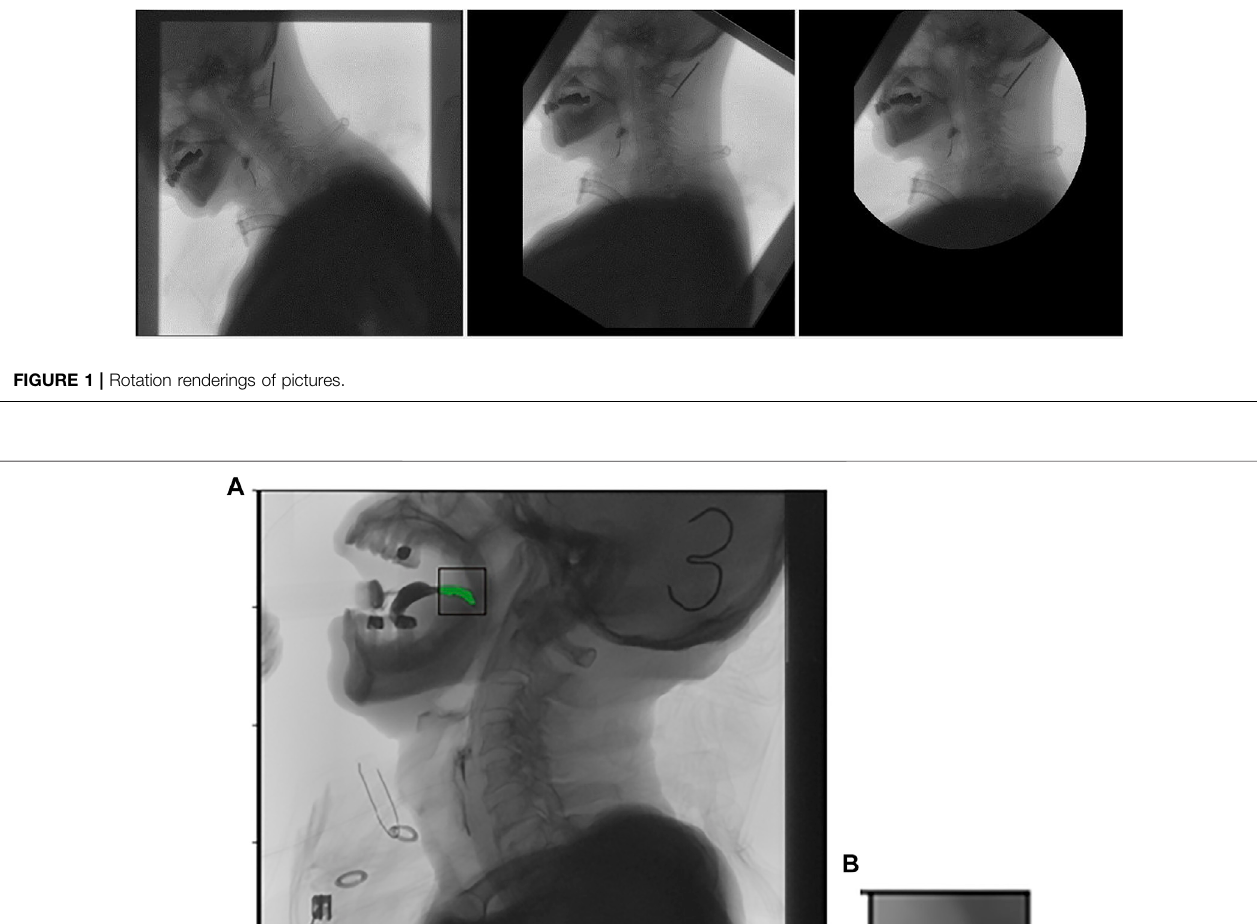
Frontiers in Physiology |